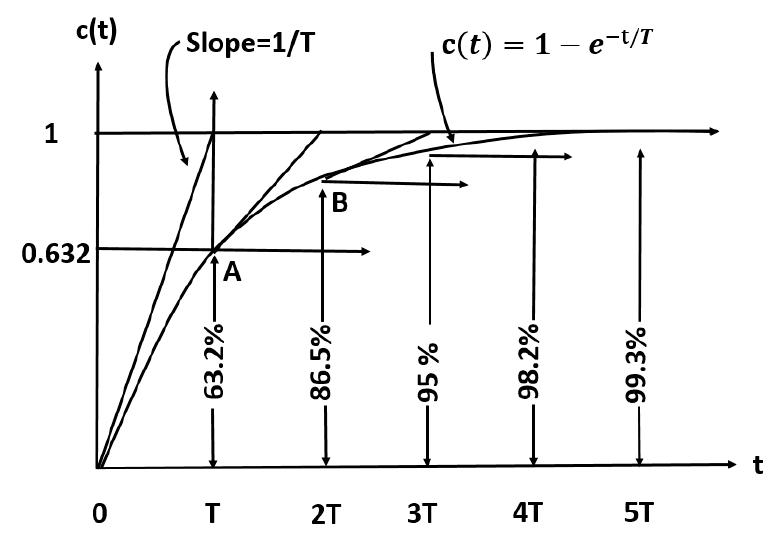
Figure 2. Theoretical exponential response curve.